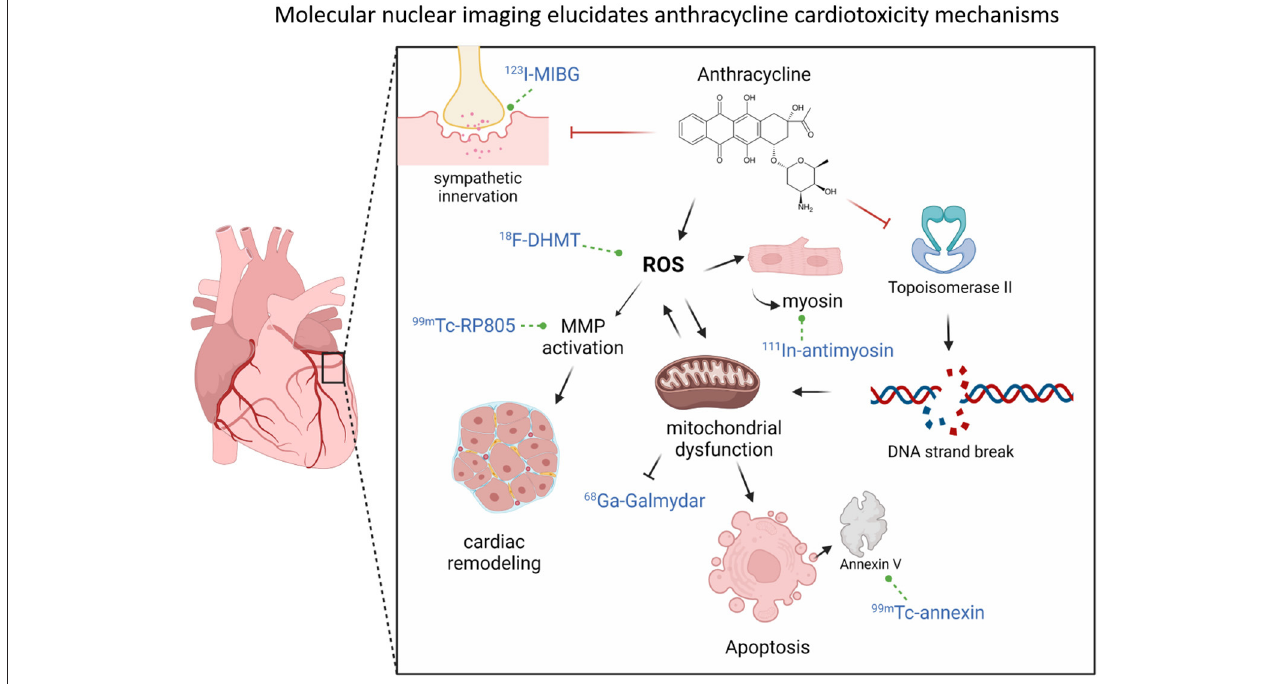
FIGURE 2 | Molecular nuclear imaging elucidates anthracycline cardiotoxicity mechanisms. Anthracyclines can increase ROS levels (which can be assessed by nuclear tracer 18 F-DHMT), which can activate MMPs (which can be assessed by 99m Tc-RP805) (bottom left), leading to adverse cardiac remodeling. ROS levels can also promote mitochondrial dysfunction, which can disrupt the mitochondrial membrane potential and thereby reduce 68 Ga-Galmydar uptake (middle bottom). Mitochondrial damage can lead to apoptosis, which can be detected by Annexin V positivity (detected by 99m Tc-Annexin (bottom right). Damage to cardiomyocytes can lead to release of intracellular myosin, which can thereby be assessed by (105). In-myosin (right of ROS). In addition to ROS increase, anthracyclines can also directly bind and inhibit Topoisomerase II, which can lead to double-stranded DNA breaks (right) and cause further mitochondrial dysfunction and